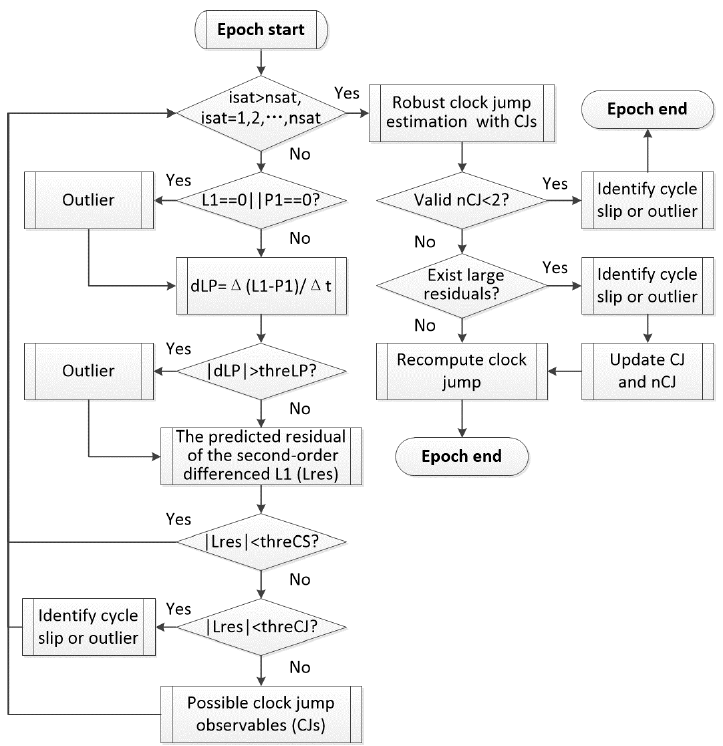
Figure 4. Flowchart of the real-time single-frequency receiver clock jump and cycle slip detection algorithm. The joint detection algorithm can handle clock steering, and the cycle slip can be detected correctly in the case of receiver clock jump.